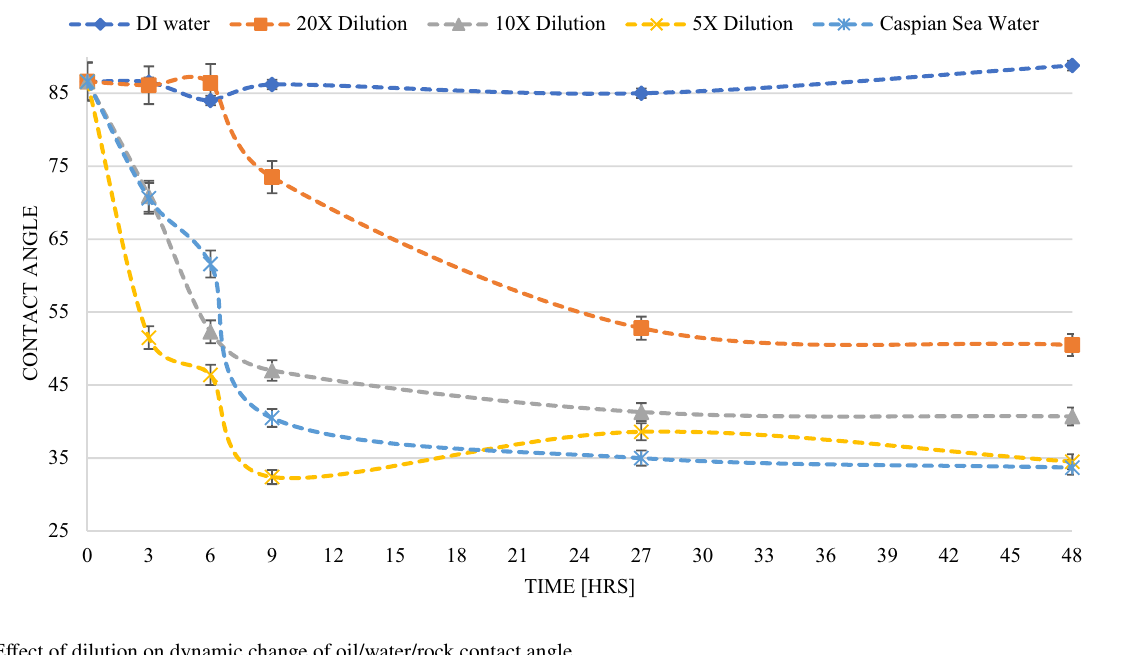
Fig. 1 Effect of dilution on dynamic change of oil/water/rock contact angle Fig. 2 Effect of PDI concentra- tion on contact angle